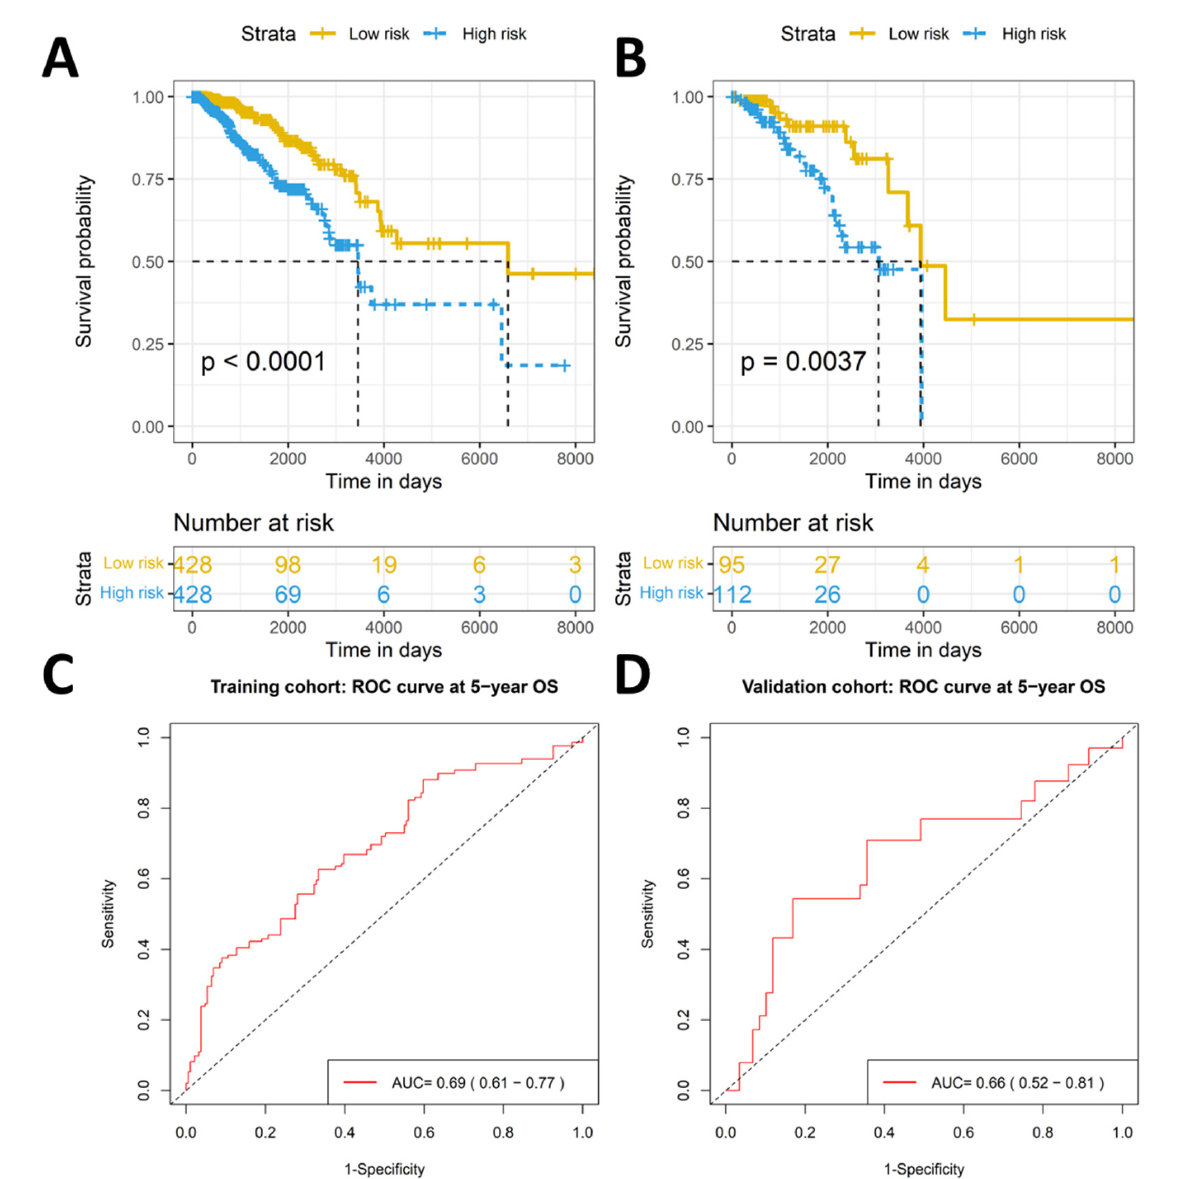
Figure 4. Kaplan–Meier survival analysis and time dependent ROC curves of the risk groups based on TRM signature for training and validation cohorts. KM curves show that the low-risk group has significantly longer overall survival compared to the high-risk group in both the training ( A ) and validation ( B ) cohorts. The AUCs of time-dependent ROC curves at 5-year OS were 0.69 and 0.66 for the training ( C ) and validation ( D ) cohorts, respectively.